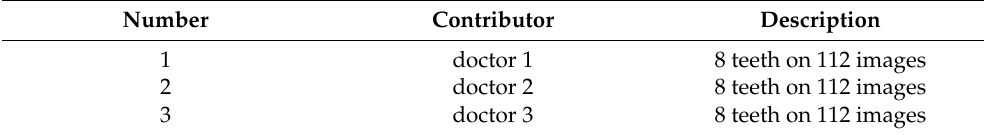
Table 1. Three test sets in the experiment and their contents. Number Contributor Description 1 doctor 1 8 teeth on 112 images 2 doctor 2 8 teeth on 112 images 3 doctor 3 8 teeth on 112 images